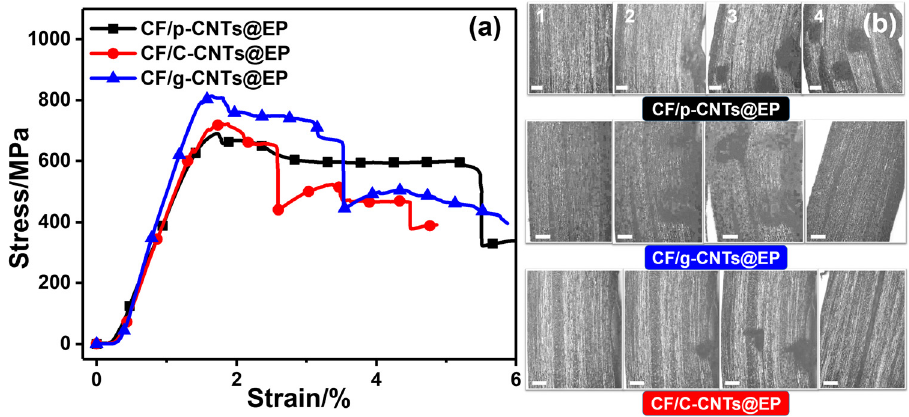
Figure 9: Flexural stress – strain curves of in situ bending test ( a ) and optical microscopic images of CF/p - CNTs@EP, CF/C - CNTs@EP, and CF/g - CNTs@EP composites via matrix enhancement method ( b ) . The scale bar is 200